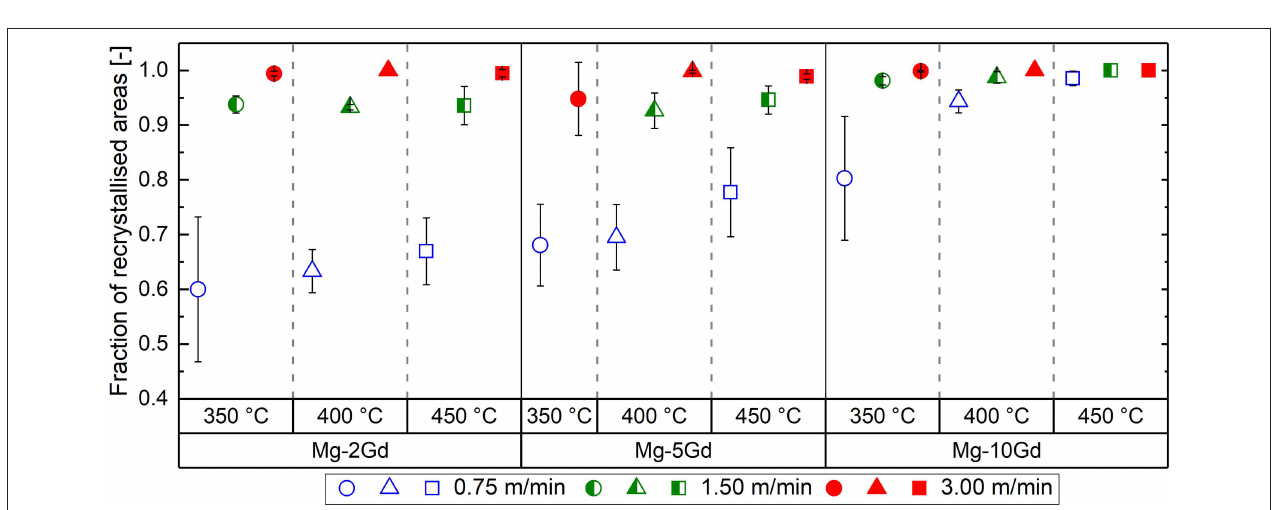
FIGURE 4 | Degree of recrystallization for all alloys with respect to extrusion parameters. Identical symbols refer to identical extrusion conditions and degree of recrystallization is comparable in between all alloys (i.e., blue circles represent 350 ◦ C and 0.75 m/min for each alloy). Error bars are standard deviations.